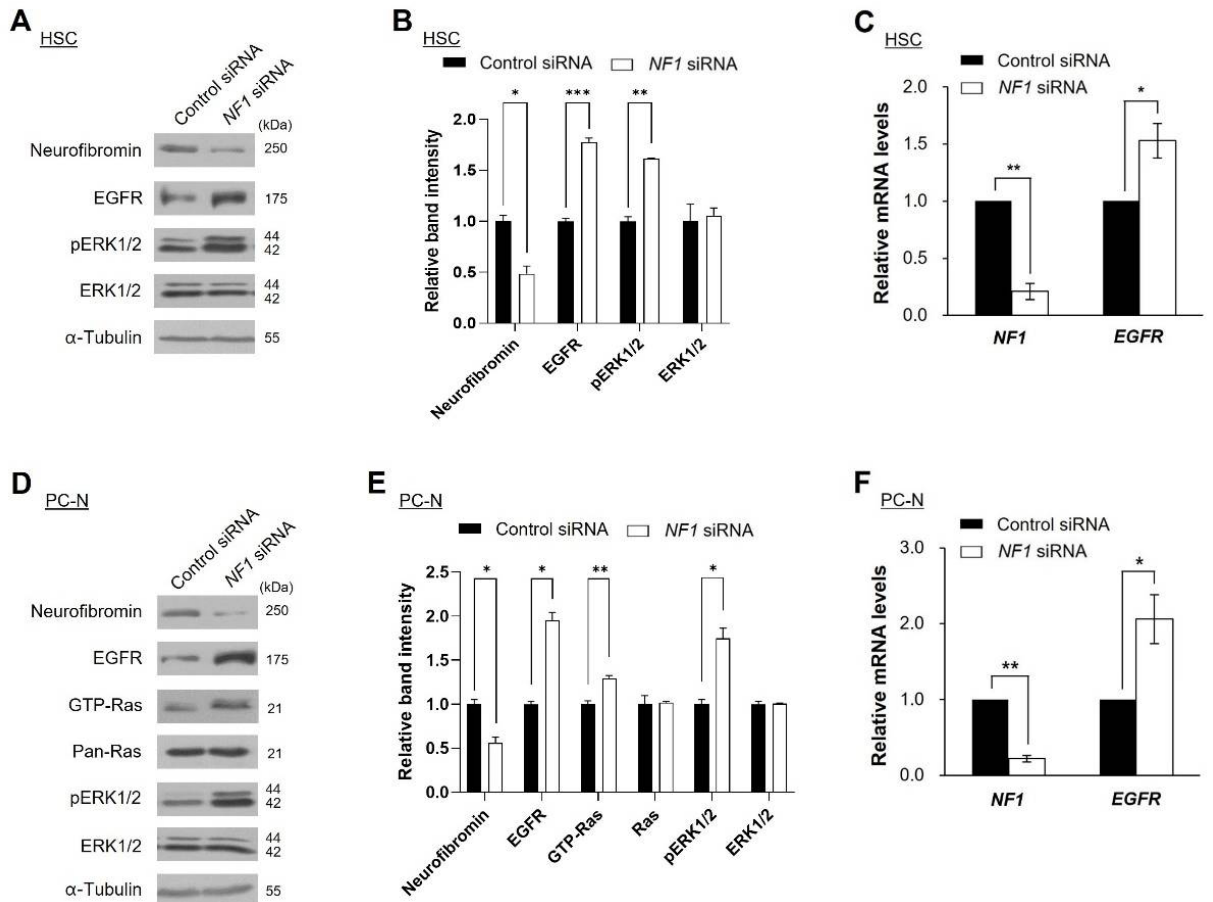
Figure 3. Correlation of the expression levels between neurofibromin and EGFR. The protein expressions of NF1 and EGFR were examined by western blot analyses following siRNA transfection in ( A ) human Schwann cells (HSCs) and ( D ) primary cultured normal (PC-N). ( B , E ) Immunoblot band density of specific proteins was normalized to the signal intensity of α-tubulin internal control for each sample. The western blot analysis was repeated at least three times with comparable results. Relative band intensity was quantified using ImageJ software. *, p < 0.05, **, p < 0.01 and ***, p < 0.001. ( C , F ) mRNA expression levels of NF1 and EGFR were evaluated by real-time quantitative RT-PCR after 3 days of transfection. Two-tailed paired t -test was used for statistical analysis. *, p < 0.05 and **, p < 0.01.